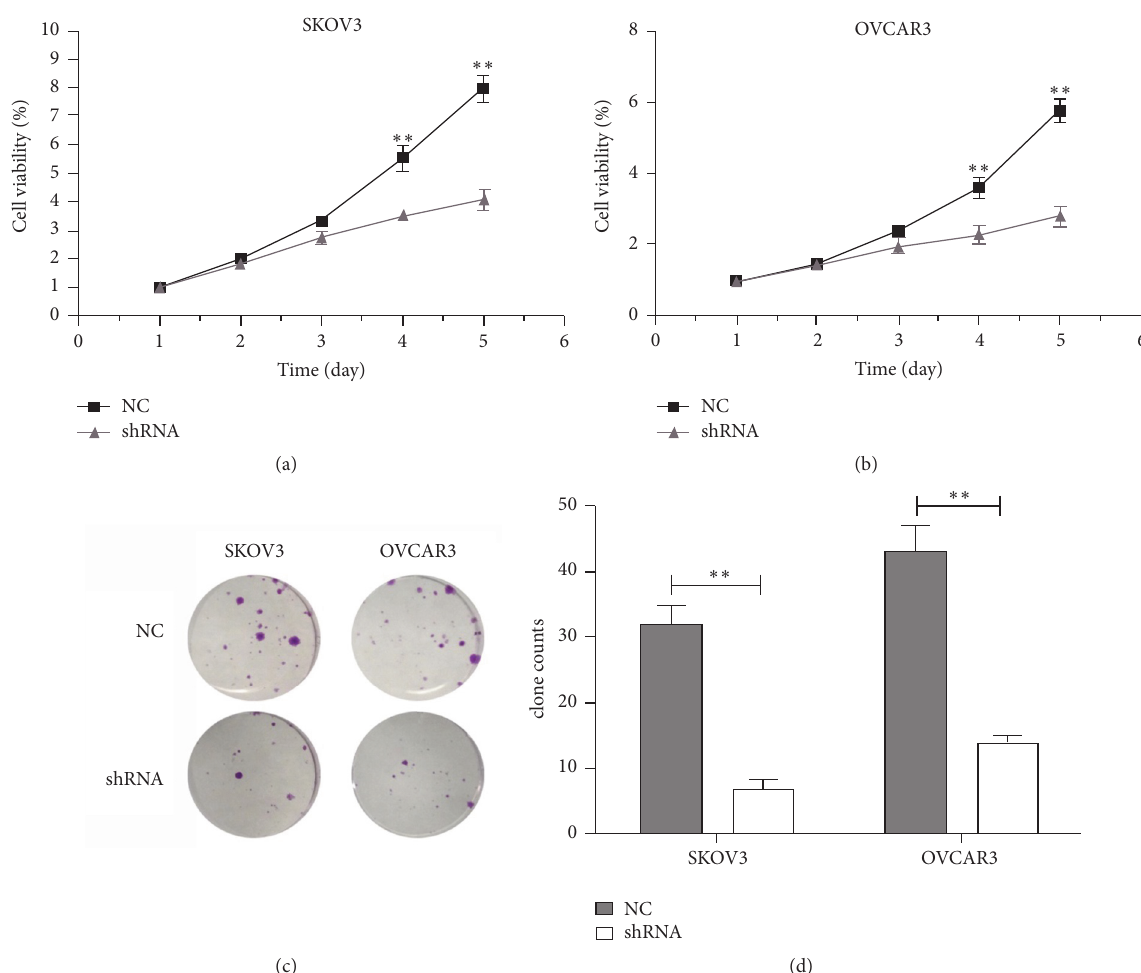
Figure 3: Knockdown of MIR4697HG inhibits cell viability and clonogenic potential in SKOV3 cells and OVCAR3 cells. (a) SKOV3 cells with (shRNA group) or without (NC group) specific shRNA transfections were subject to cell viability assessment for consecutive 5 days. (b) OVCAR3 cells with (shRNA group) or without (NC group) specific shRNA transfections were subject to cell viability assessment for consecutive 5 days. (c) Both SKOV3 cells and OVCAR3 cells with (shRNA group) or without (NC group) specific shRNA transfections were subject to colony formation assays. After crystal violet staining, colonies were visually less observed in MIR4697HG-depleted SKOV3 cells and OVCAR3 cells. (d) Counting of colonies showed that colony numbers were significantly decreased by 75% in MIR4697HG-depleted SKOV3 cells and 66% in MIR4697HG-depleted OVCAR3 cells. ∗∗ 𝑝 < 0.01 .